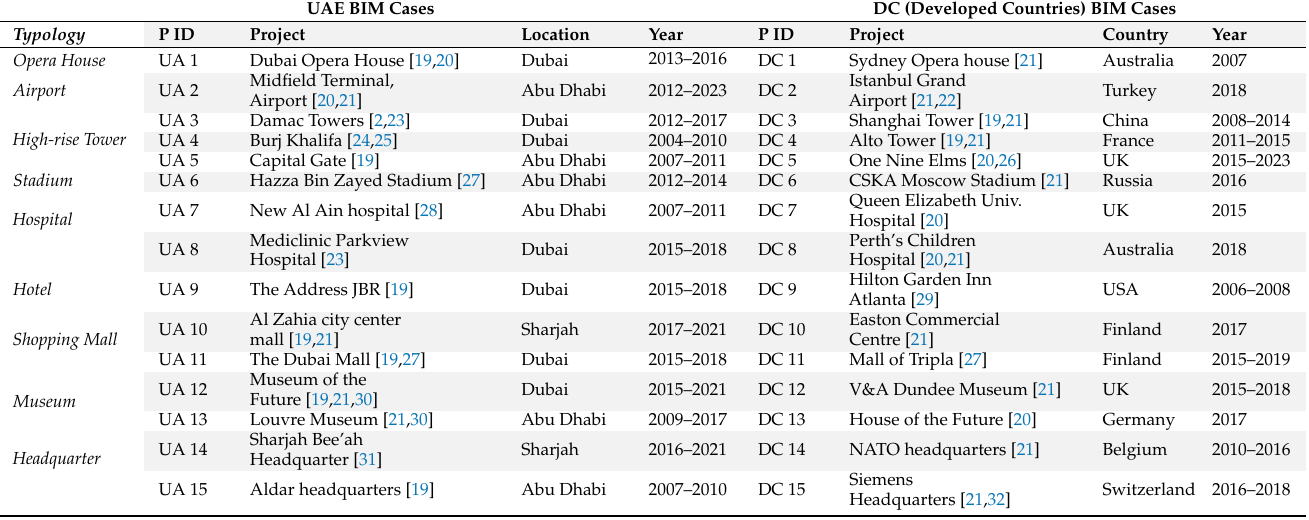
Table 1. BIM Projects: Cases from UAE and Developed